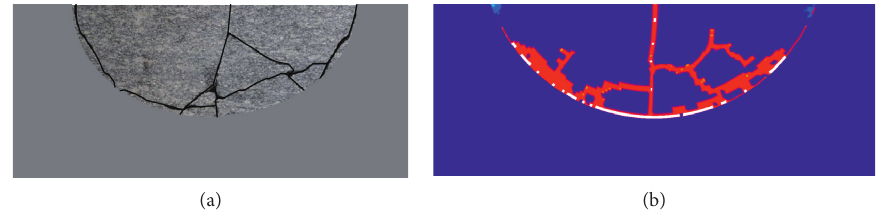
Figure 3: The arc rock plate breaking results of experiments and numerical simulation. (a) The arc rock plate breaking results of experiment. (b) The arc rock plate breaking results of numerical simulation.